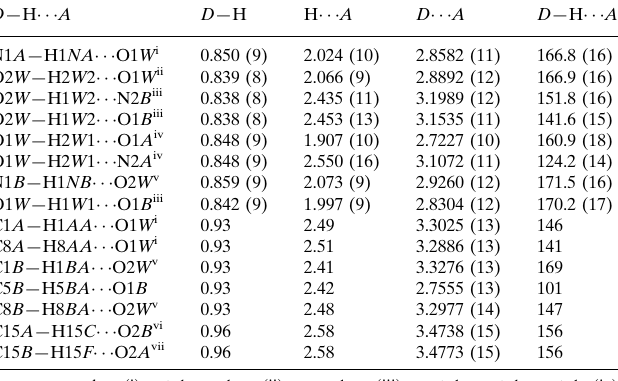
Experimental Crystal data Data collection Bruker SMART APEXII CCD area-detector diffractometer Absorption correction: multi-scan ( SADABS ; Bruker, 2005) T min = 0.959, T max = 0.990 R [ F 2 > 2 (cid:1) ( F 2 )] = 0.048 wR ( F 2 ) = 0.155 S = 1.07 11039 reflections